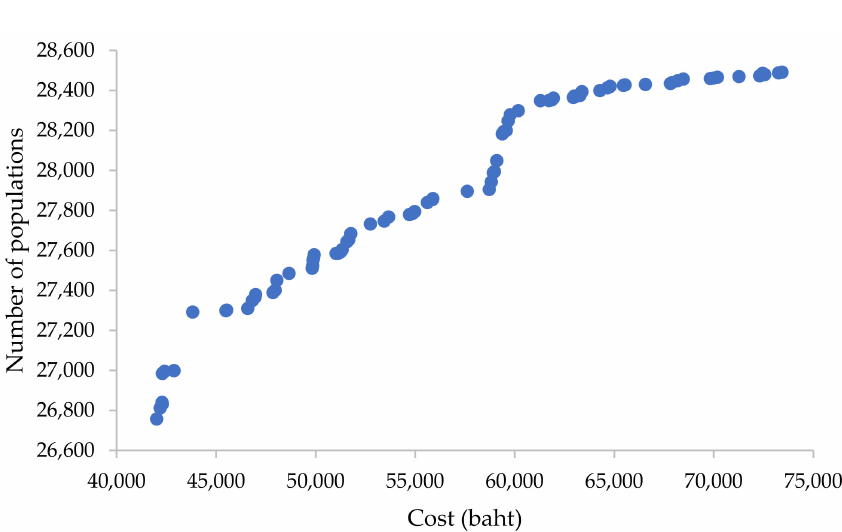
Figure 7. Pareto front of